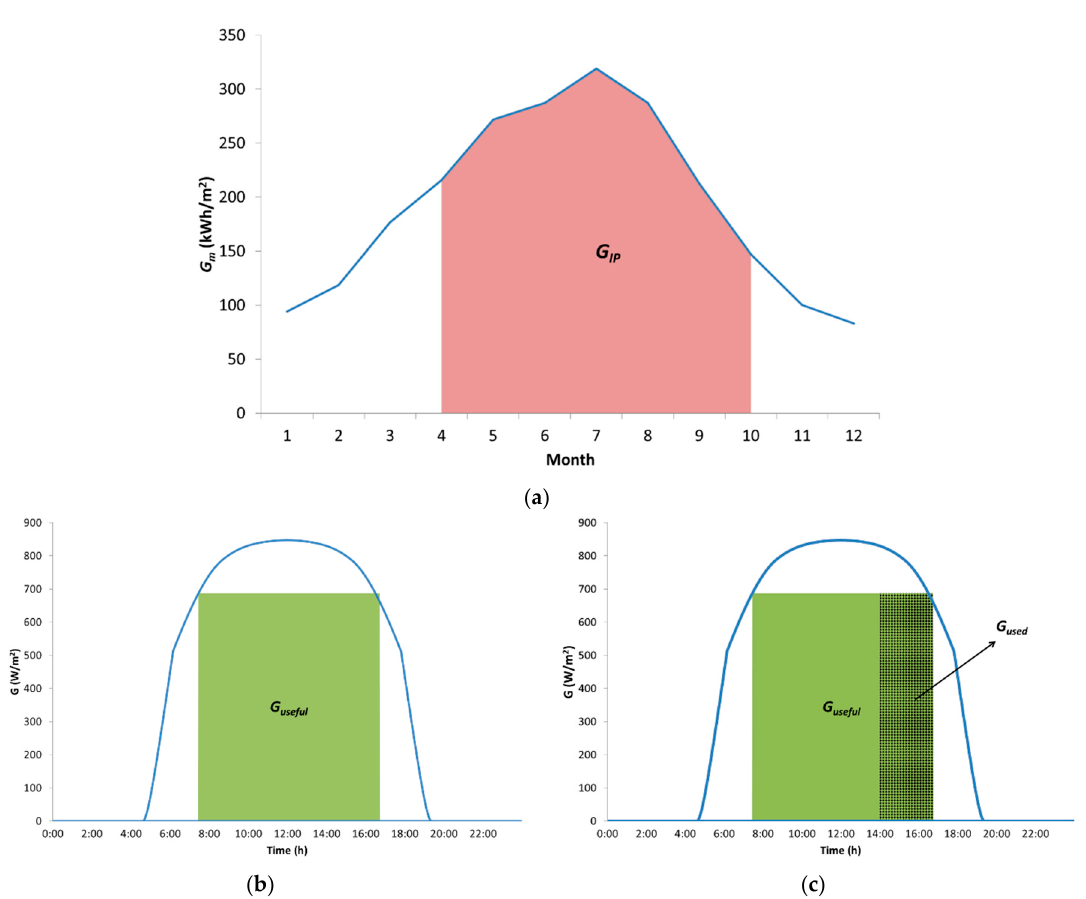
(cid:82) G IP is the irradiation